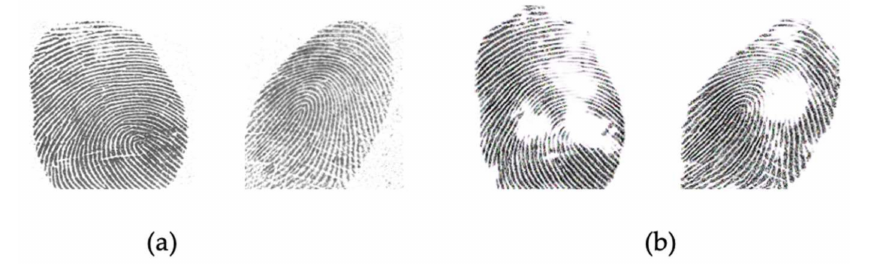
Figure 9. Image conversion from GreenBit domain ( a ) to the joint domains ( b ) of other sensors.